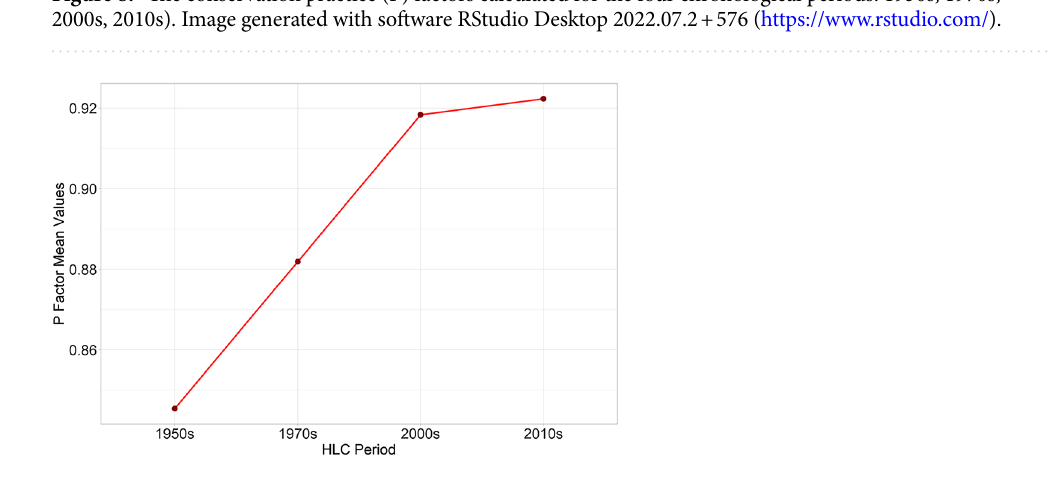
Figure 9. The P factors mean values in the four chronological periods: 1950s, 1970s, 2000s, 2010s). Image generated with software RStudio Desktop 2022.07.2 + 576 (https:// www. rstud io.